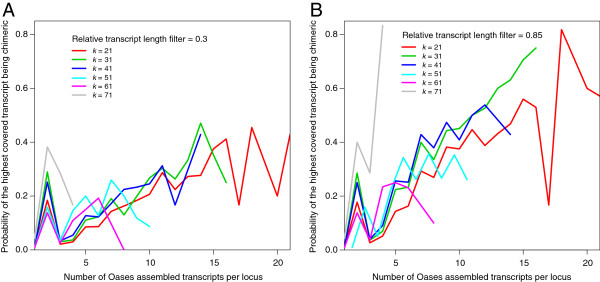
Parameters for choosing the representative transcript for each locus in Oases. (A) Only considering transcripts that are longer than 0.3 of the longest transcript in the same locus; (B) only considering transcripts that are longer than 0.85 of the longest transcript in the same locus. A data point is plotted only when there are five or more loci of the same size in each data set.